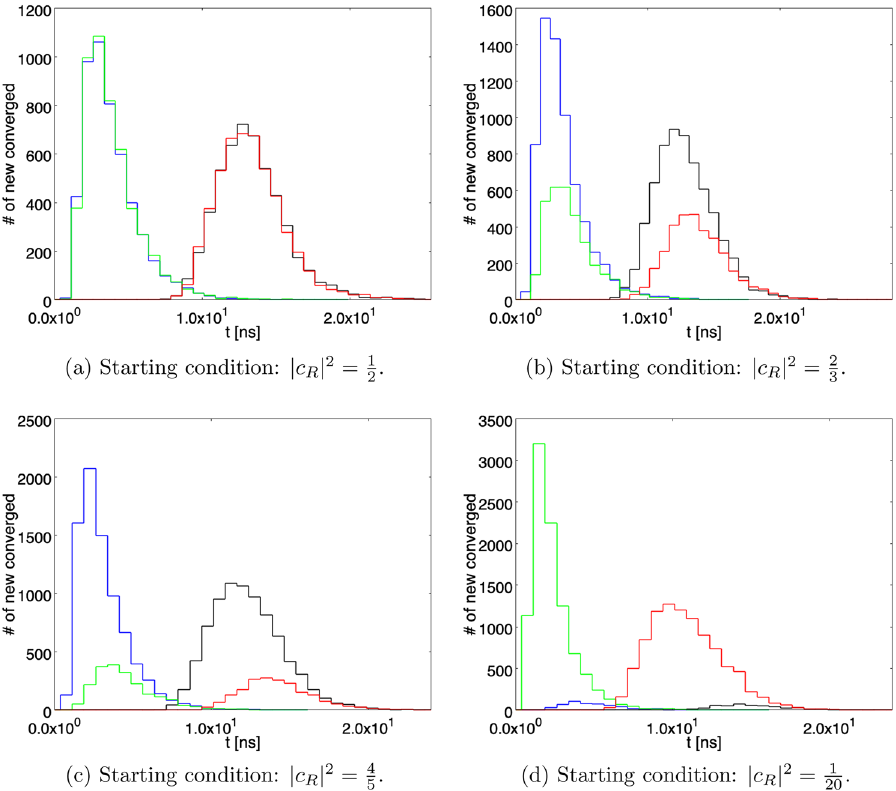
2 ≥ 1 − 𝜀 (blue and black histograms for von c R 2 ≤ 𝜀 (green and red histograms c | | R | |